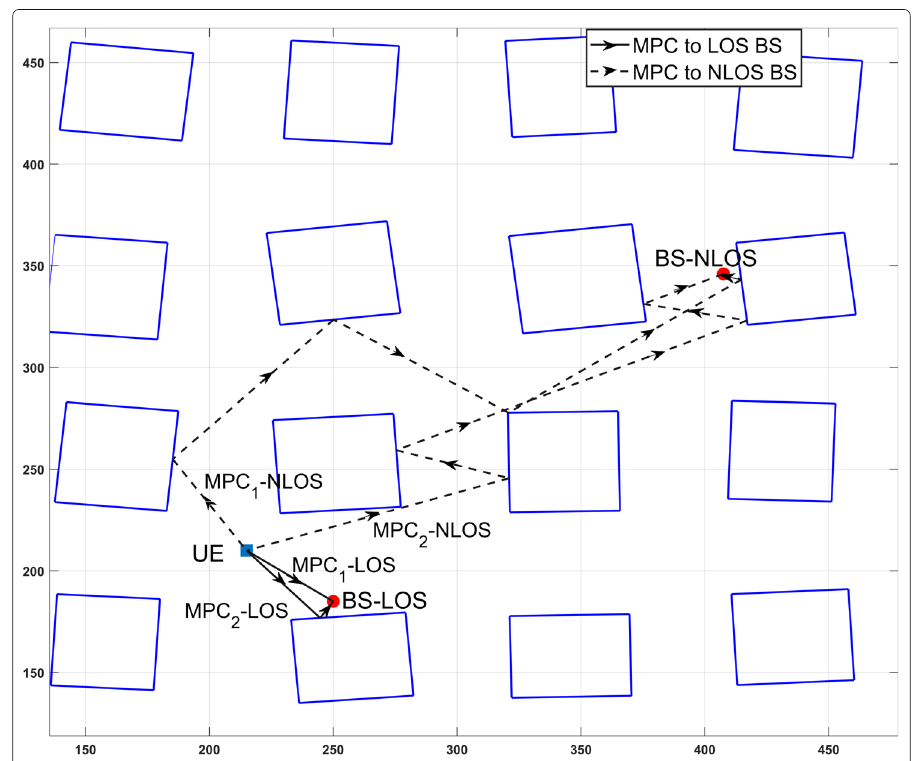
Fig. 6 A scenario showing the propagation paths and MPCS for a UE location with LOS and NLOS